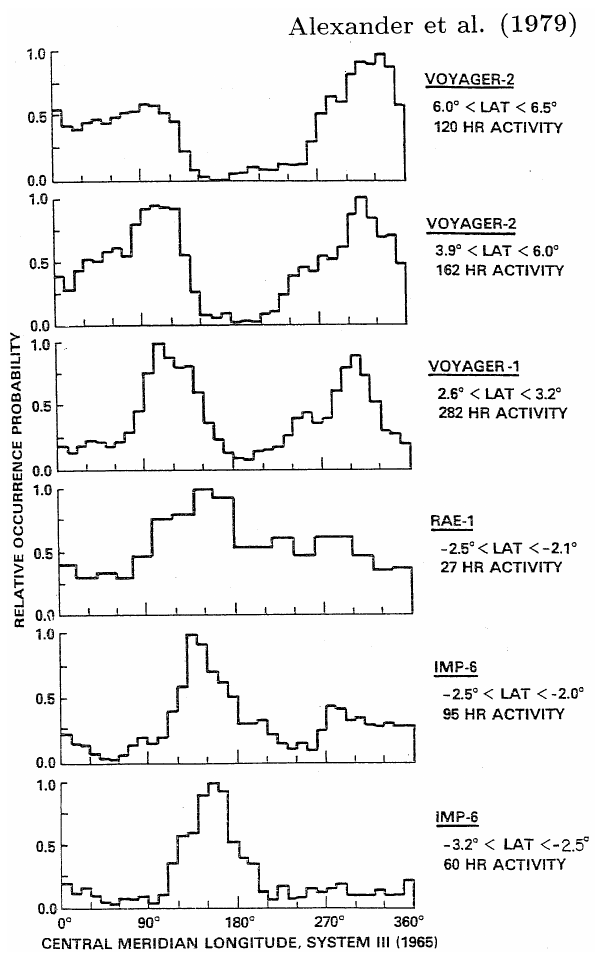
Fig. 6. Relative occurrence probability of the HOM for the range of jovicentric latitudes − 3 . 2 ◦ to 6 . 5 ◦ (from Alexander et al., 1979).